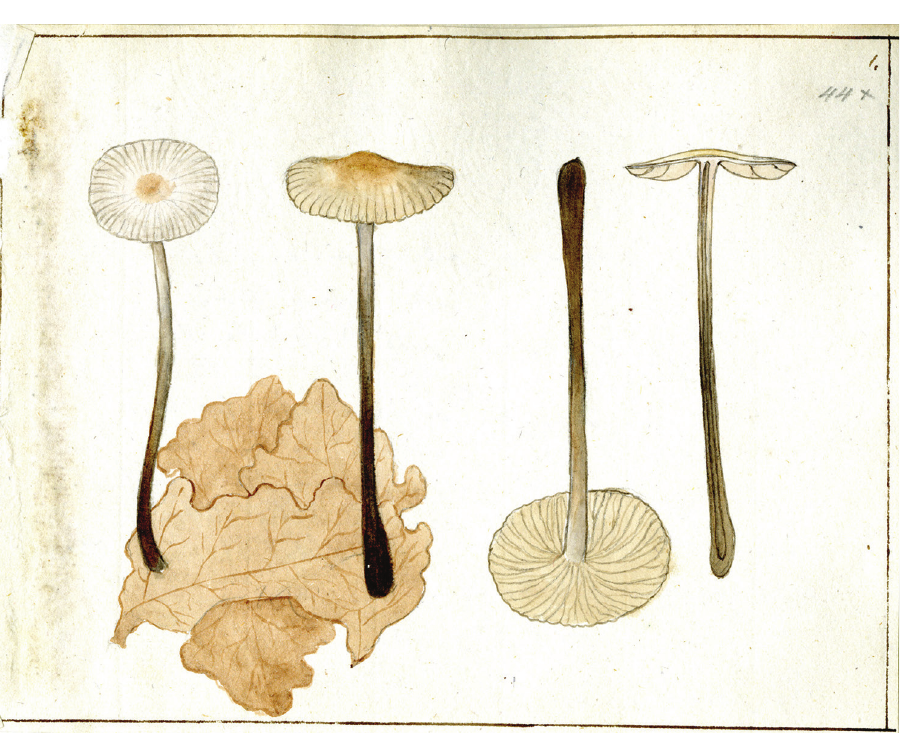
Figure 93. Schumacher’s unpublished illustration of Agaricus allicinis